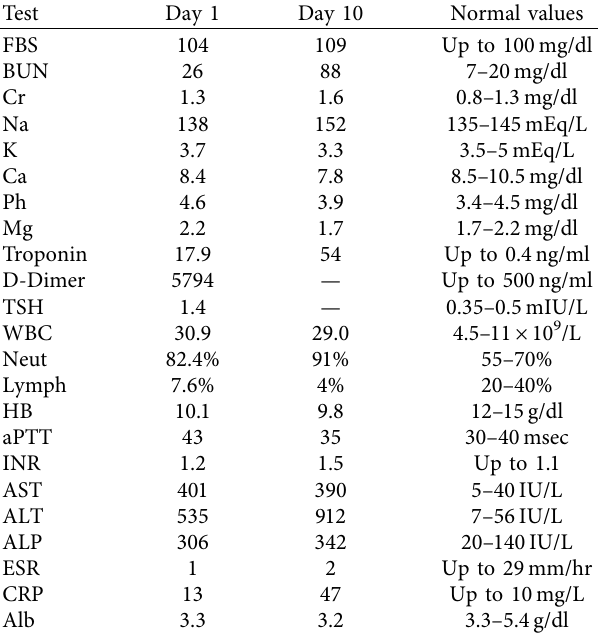
Table 1: Laboratory test results.